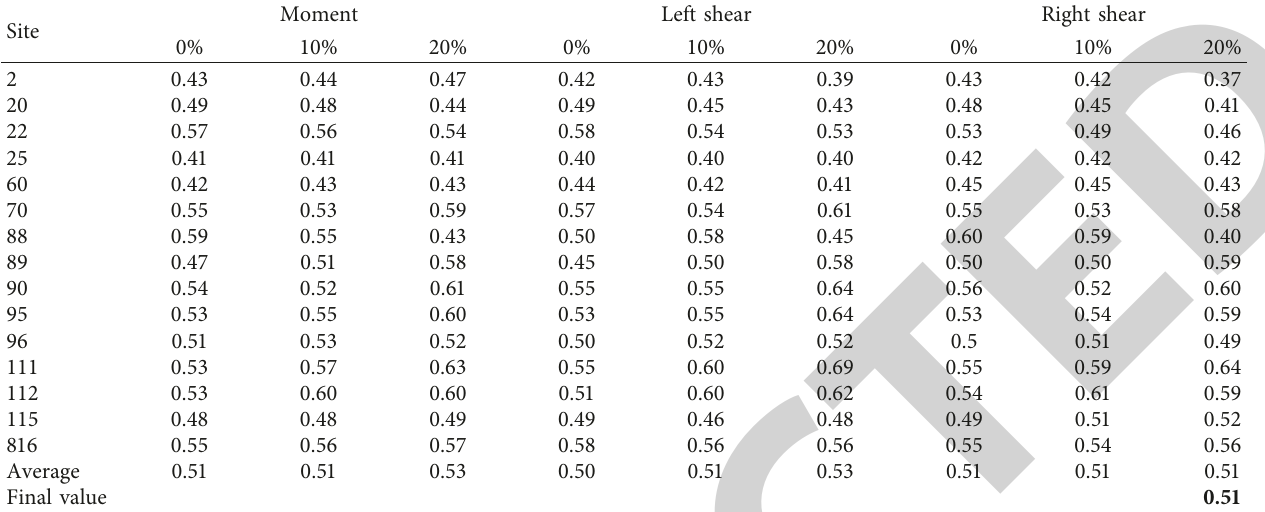
Table 5: Ratios for equation (11) and the 15